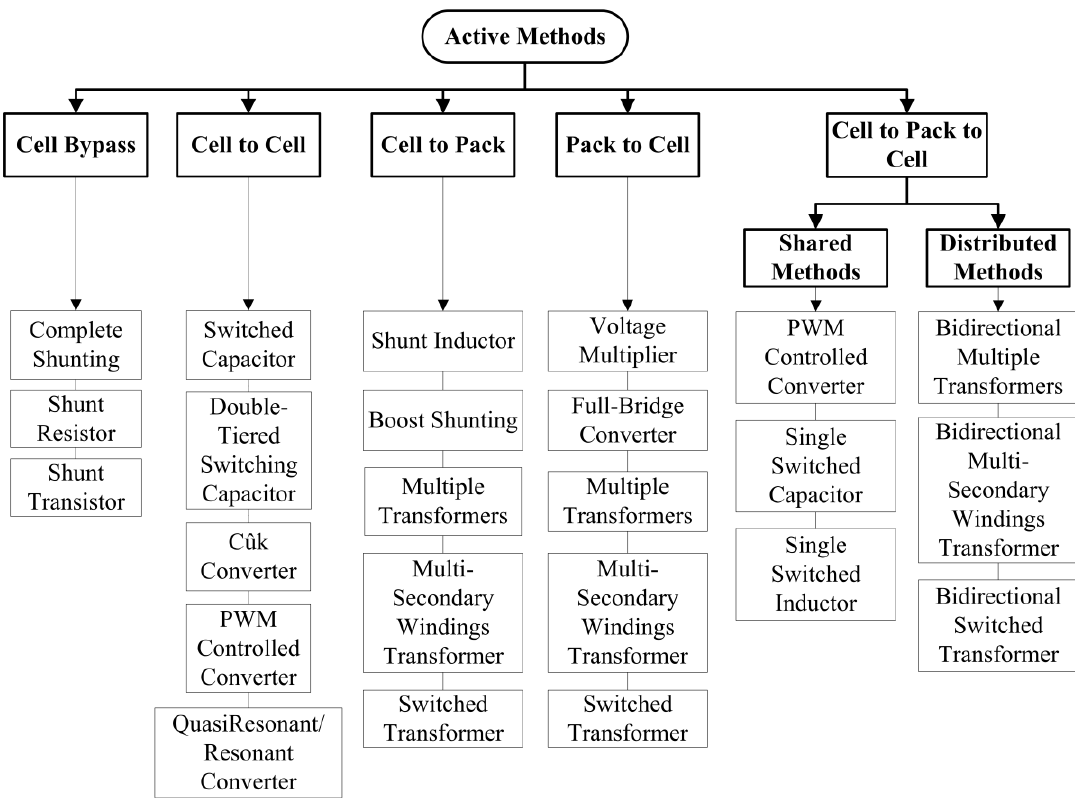
Fig. 2. Classification of the different active balancing